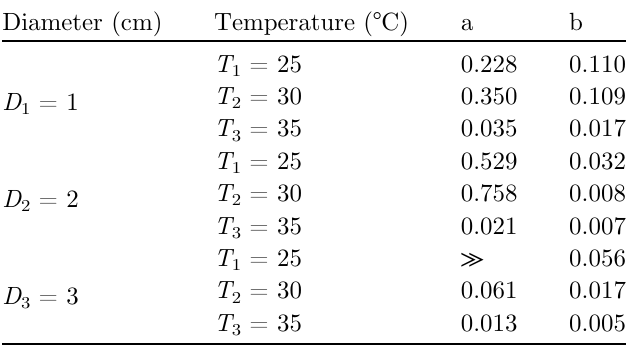
Table 5. Parameters of the presented polynomial fl ux model for